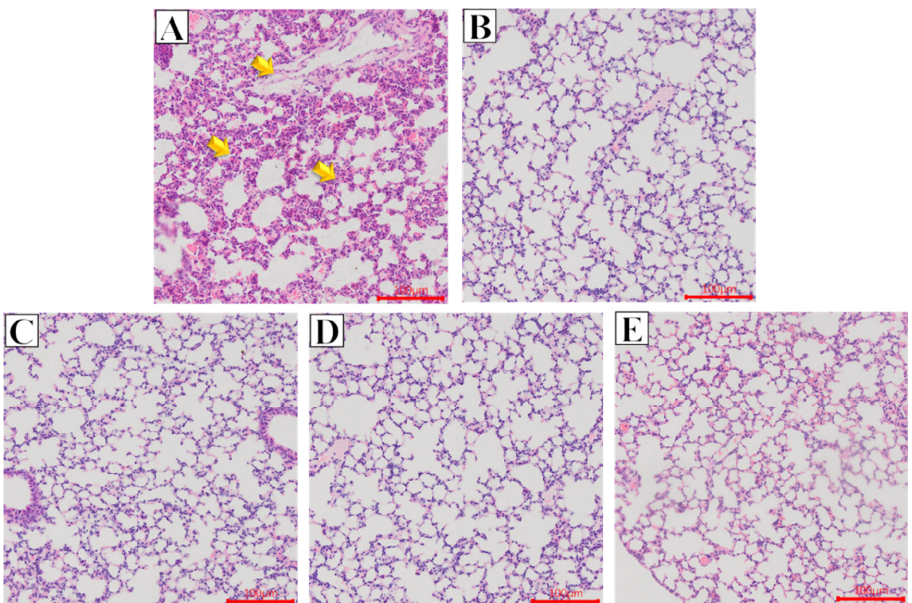
Figure 6. Effect of Glycine nano-selenium on pathological changes of lung tissue in mice immunized with H9N2 avian influenza virus vaccine and challenged with H9N2 avian influenza virus ( A – E , 200×); ( A ) Control challenged group showed obvious symptoms of virus infection, thickening of lung texture, thickening of lung septum, alveolar atrophy, proliferation of connective tissue, and increase of inflammatory cells (the lesion site was marked by yellow arrow); ( B – E ) The lung texture of mice in the positive, low, medium, and high dose challenged groups was clear, the alveolar structure was complete, and there were no obvious pathological changes (n = 5).